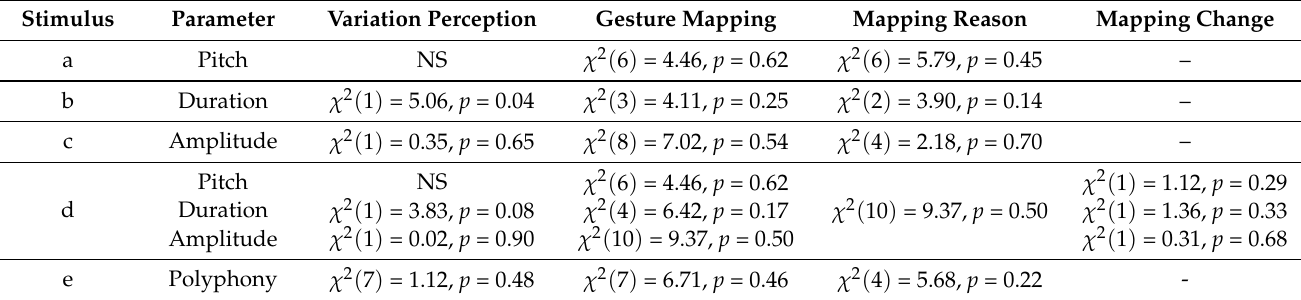
Table A27. Phase 1 profile associations. NS: Value is constant.